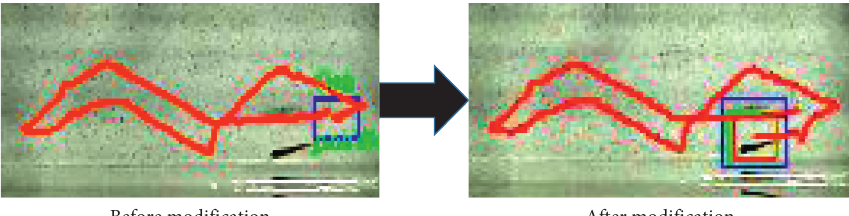
Figure 4: Actual tracking effect of the kernel-related filtering algorithm before and after modification.